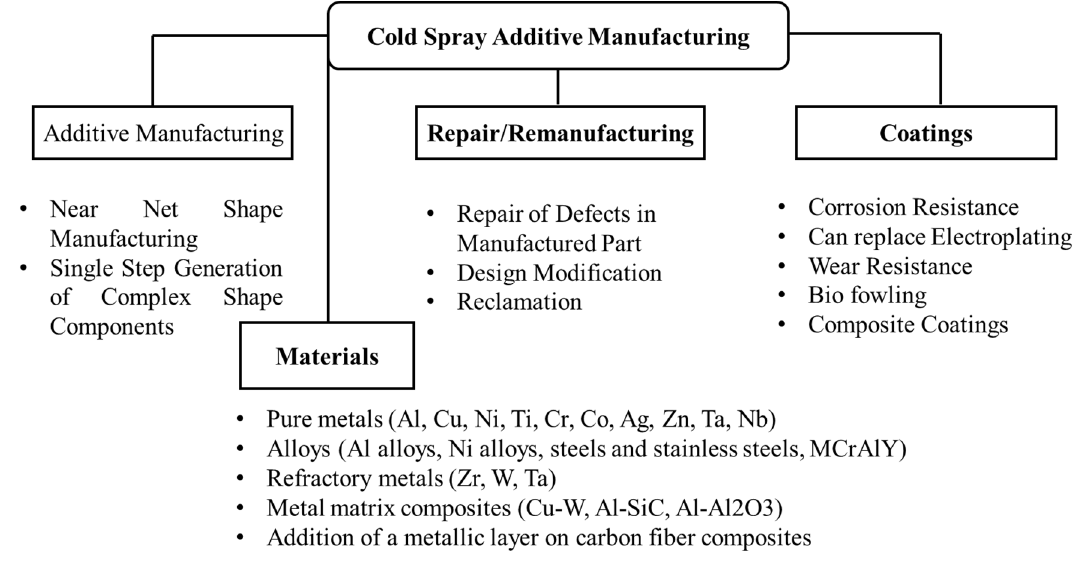
Figure 15. Key features of cold spray as additive manufacturing.